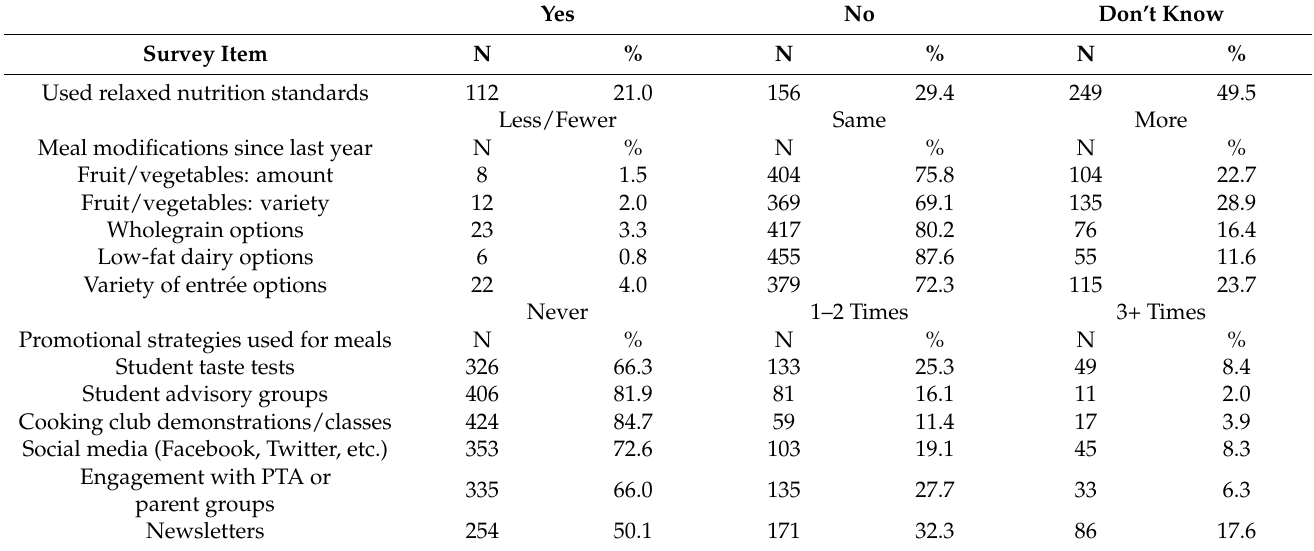
Table 3. Survey responses regarding meal flexibilities/modifications and strategies used to promote school meals at 542 US public elementary schools, 2019–20 school